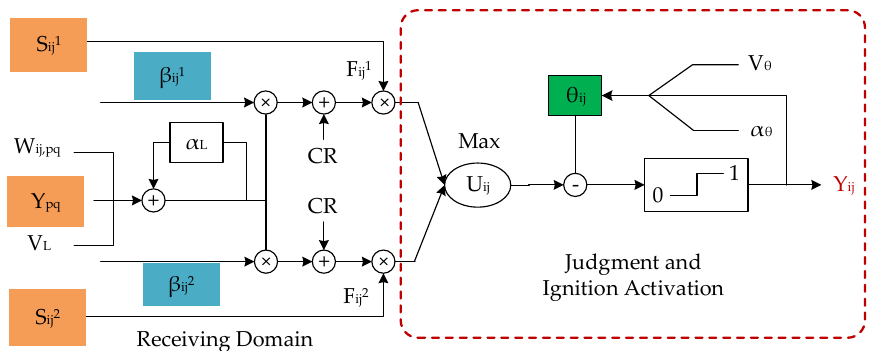
Figure 2. DPCNN model. Multiplication, summation, and difference between two sides are represented by symbols ⊗ , ⊕ , and ⊝ , respectively.